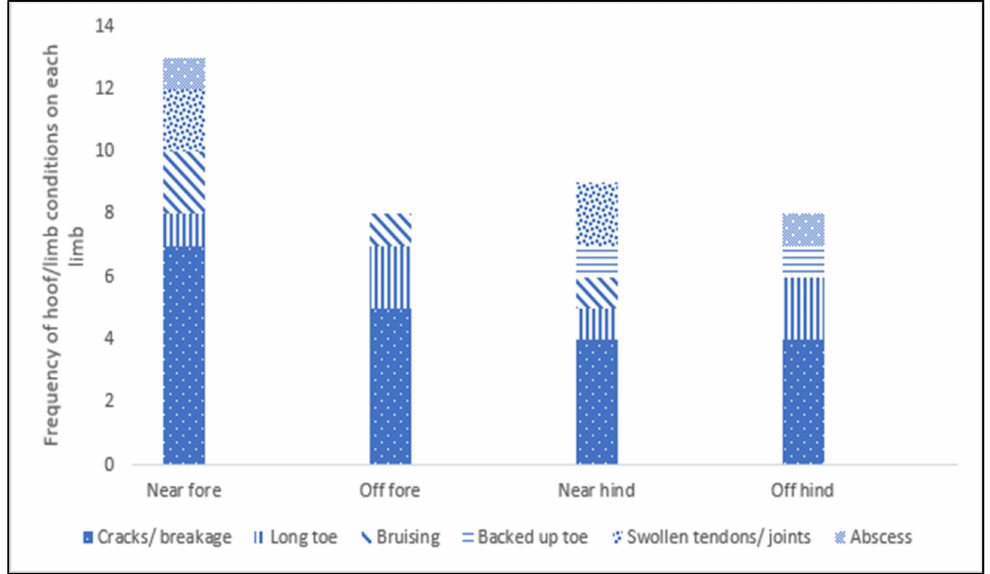
Figure 3. Frequency of hoof/limb conditions on each limb of horses